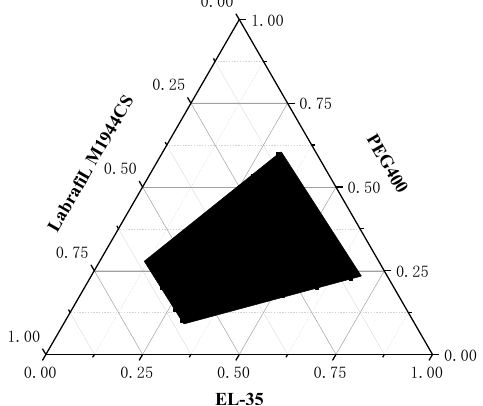
Figure 3. Ternary phase diagram of the blank self-microemulsifying drug delivery system (SMEDDS). The black area represents the microemulsion region, and the white area represents the coarse emulsion region.